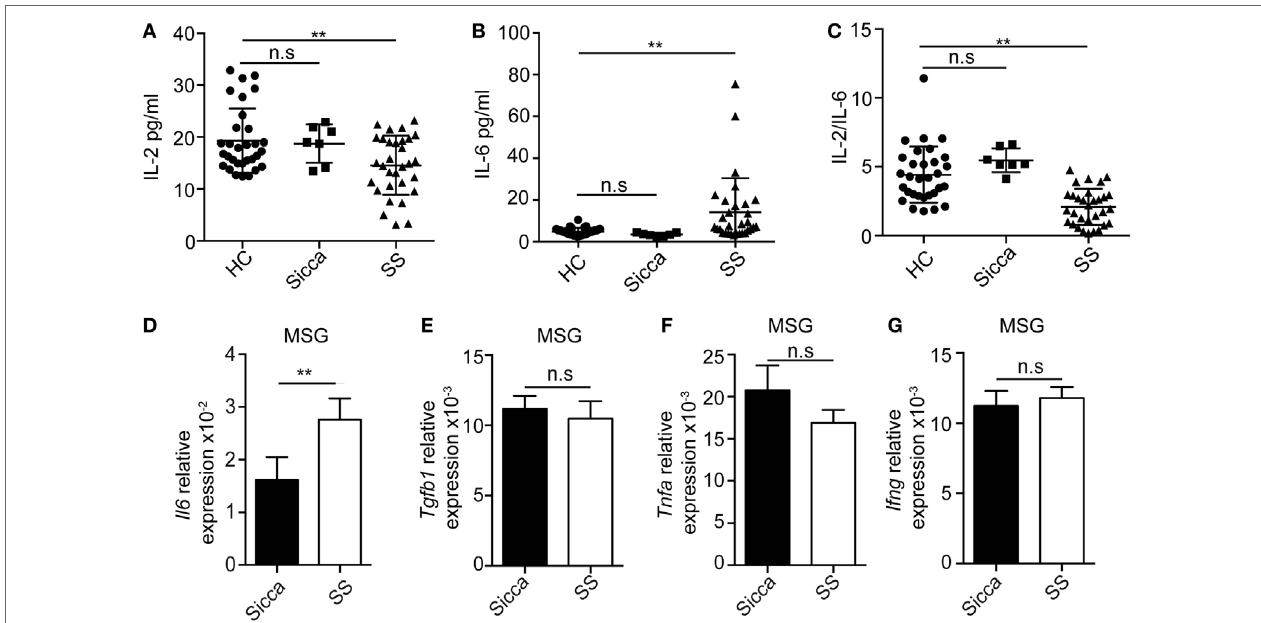
FigUre 2 | Enhanced IL-6 but reduced IL-2 expression in primary Sjögren’s syndrome (pSS) patients. (a–c) Serum levels of IL-2 (a) , IL-6 (b) , and IL-2/IL-6 (c) were determined by ELISA in the healthy subjects ( n = 31), Sicca ( n = 7), and pSS patients ( n = 31). (D–g) Expressions of Il6 (D) , Tgfb1 (e) , Tnfa (F) , and Ifng (g) mRNAs in the minor salivary gland (MSG) from either Sicca patients or pSS patients were determined by q-PCR. ** p <